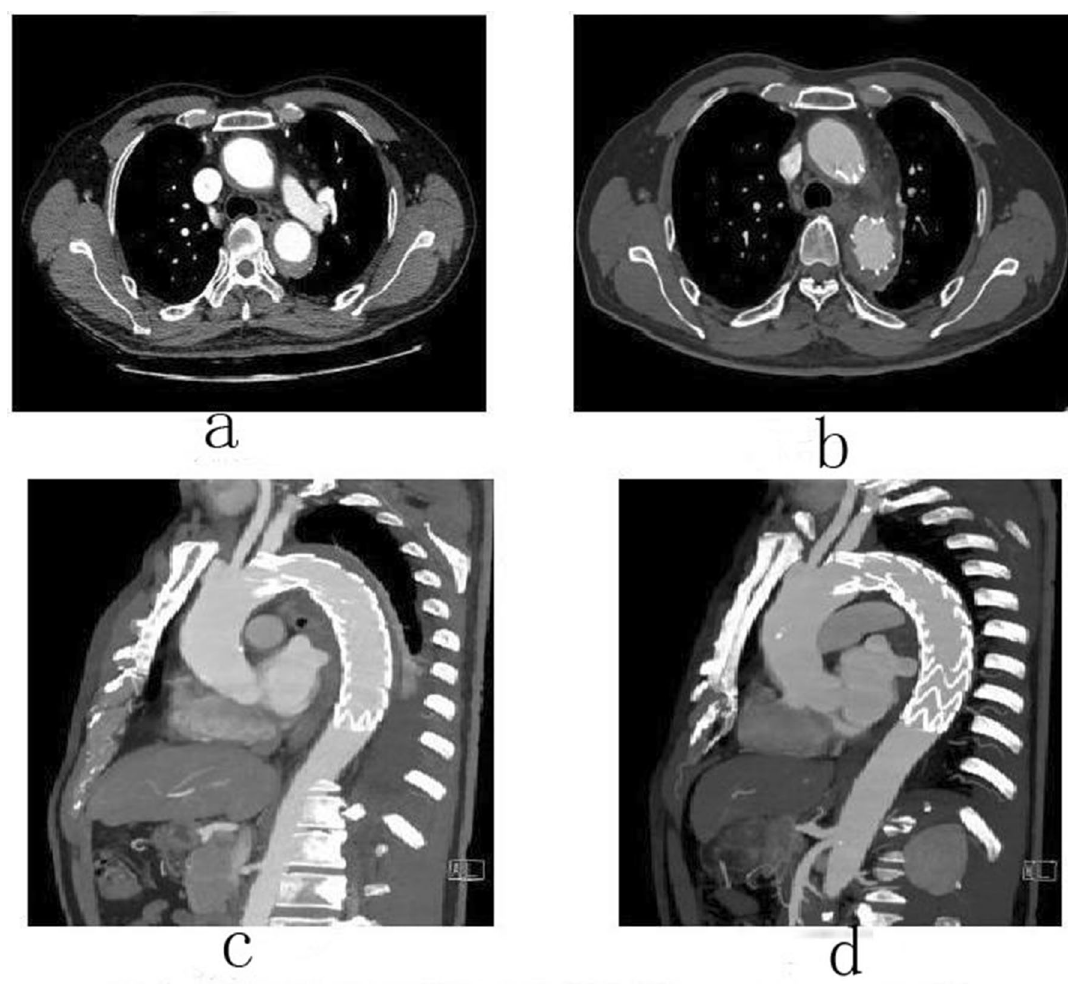
Figure 2. Male, 62 years old, admitted to hospital for “repetition of chest and back pain for 9 h”. Diagnosis: Standford A IMH TEVAR. CTA of the patient in different periods: ( a ) Admission; ( b ) 5 days after surgery; ( c ) 5 days after surgery; ( d ) 3 months after